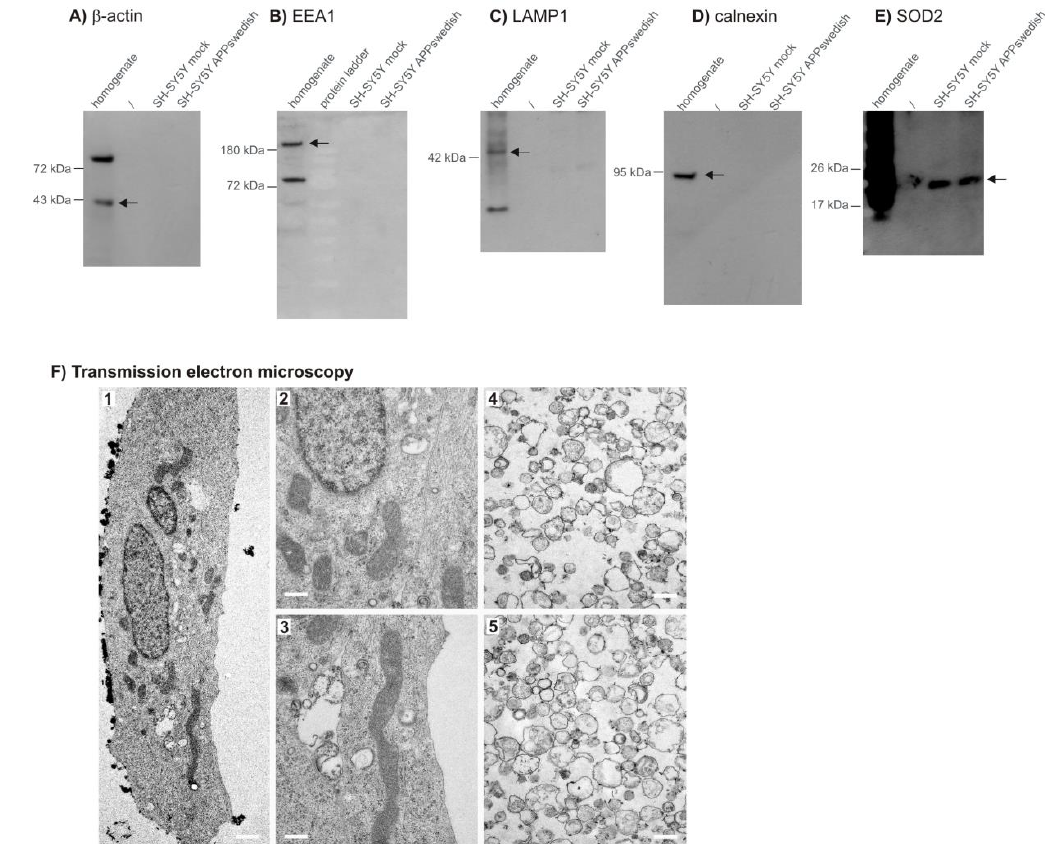
Figure 1. Verification of the mitochondrial preparations by Western blot analysis and transmission electron microscopy. ( A ) Protein level of β-actin in homogenate (lane 1) and the absence of this major component of the cytoskeleton in samples of isolated mitochondria from SH-SY5Y mock- or APPswedish transfected cells (lanes 3–4). ( B ) Early Endosomal Antigen 1 (EEA1) protein level in homogenate (lane 1) and the absence of this early endosome-associated protein in samples of isolated mitochondria from SH-SY5Y mock or APPswedish transfected cells (lanes 3–4). ( C ) Protein level of LAMP1 in homogenate (lane 1) and the absence of this lysosomal-associated membrane protein in samples of isolated mitochondria from SH-SY5Y mock or APPswedish transfected cells (lanes 3–4). ( D ) Calnexin protein level in homogenate (lane 1) and the absence of this integral protein of the endoplasmic reticulum in samples of isolated mitochondria from SH-SY5Y mock or APPswedish transfected cells (lanes 3–4). ( E ) Protein level of superoxide dismutase 2 (SOD2) in homogenate (lane 1) and in samples of isolated mitochondria from SH-SY5Y mock or APPswedish transfected cells (lanes 3–4). ( F ) Transmission electron microscopy of SH-SY5Y APPwt cells and isolated mitochondria. 1: A typical SH-SY5Y APP cell with mitochondria distributed throughout the cell at 2000× magnification. 2–3: 12,000× magnification of mitochondria from 1). 4–5: Mitochondrial fraction specifically isolated from SH-SY5Y APP cells at 12,000× magnification. Round structures in the range of 200–800 nm are visible, indicating a pure mitochondrial fraction without contamination with other cell organelles. The internal membrane structures of the mitochondria are largely collapsed due to preparation. Scale bars: 1: 1000 nm; 2–5: 500 nm.